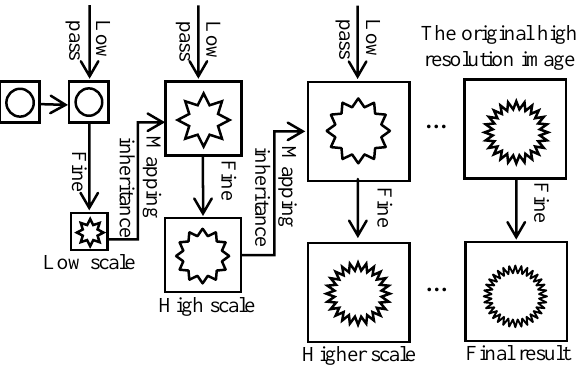
Figure 1. The flowchart of exponential multi-scale C-V model of level